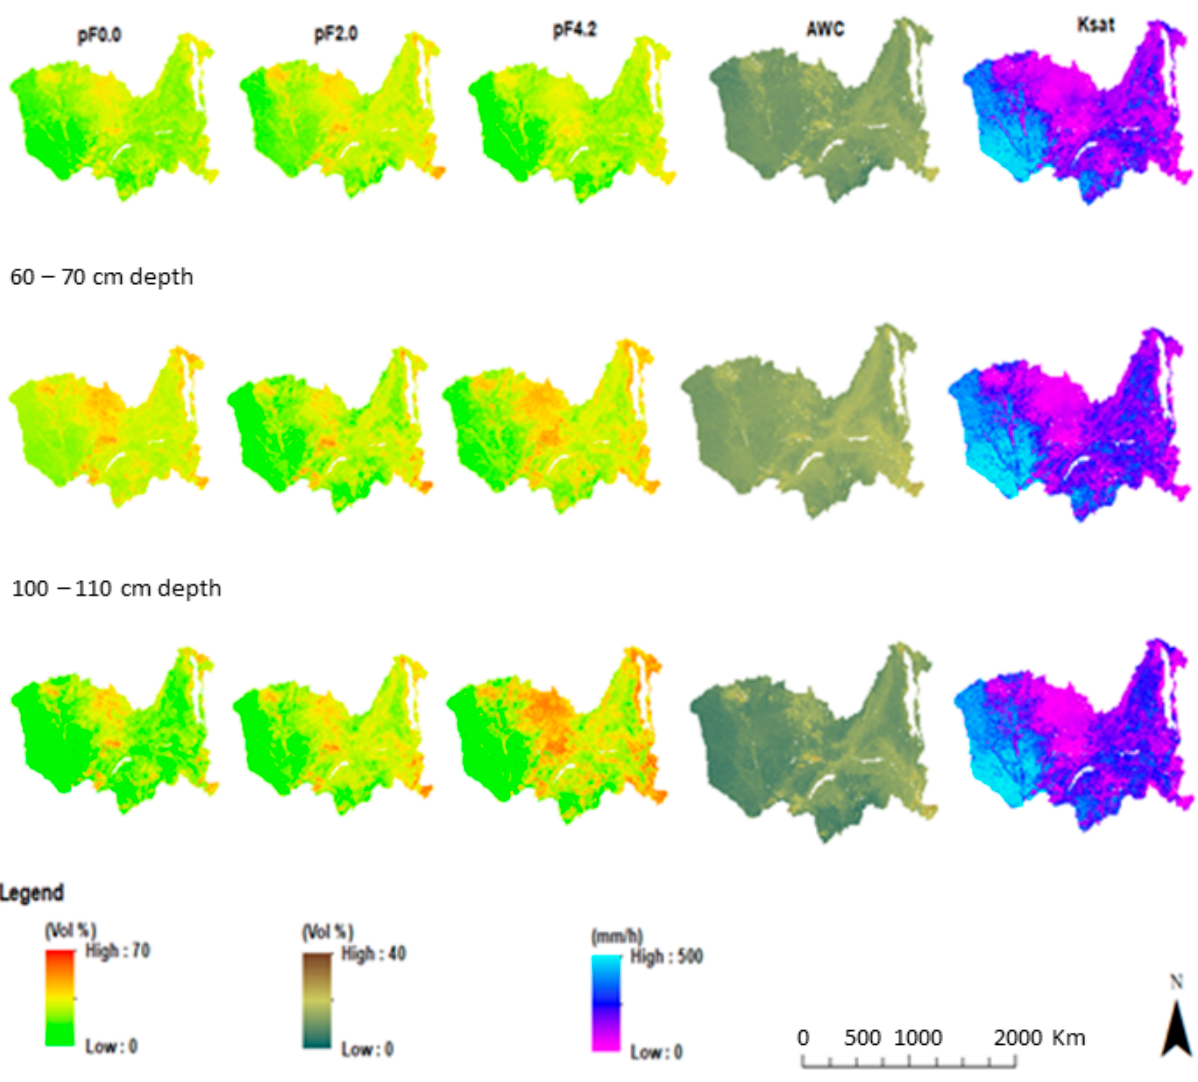
Figure 2. Maps of soil hydraulic properties at a depth of 30–40 cm, 60–70 cm, and 100–110 cm for the ZRB used in AquaCrop simulations.